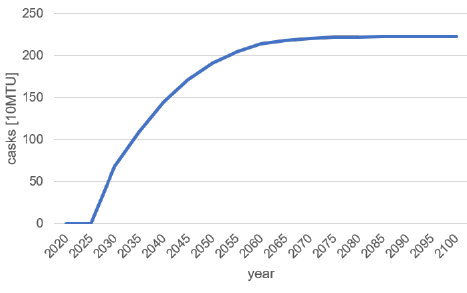
Figure 11. Overall storage level of vitrified waste. Source: own